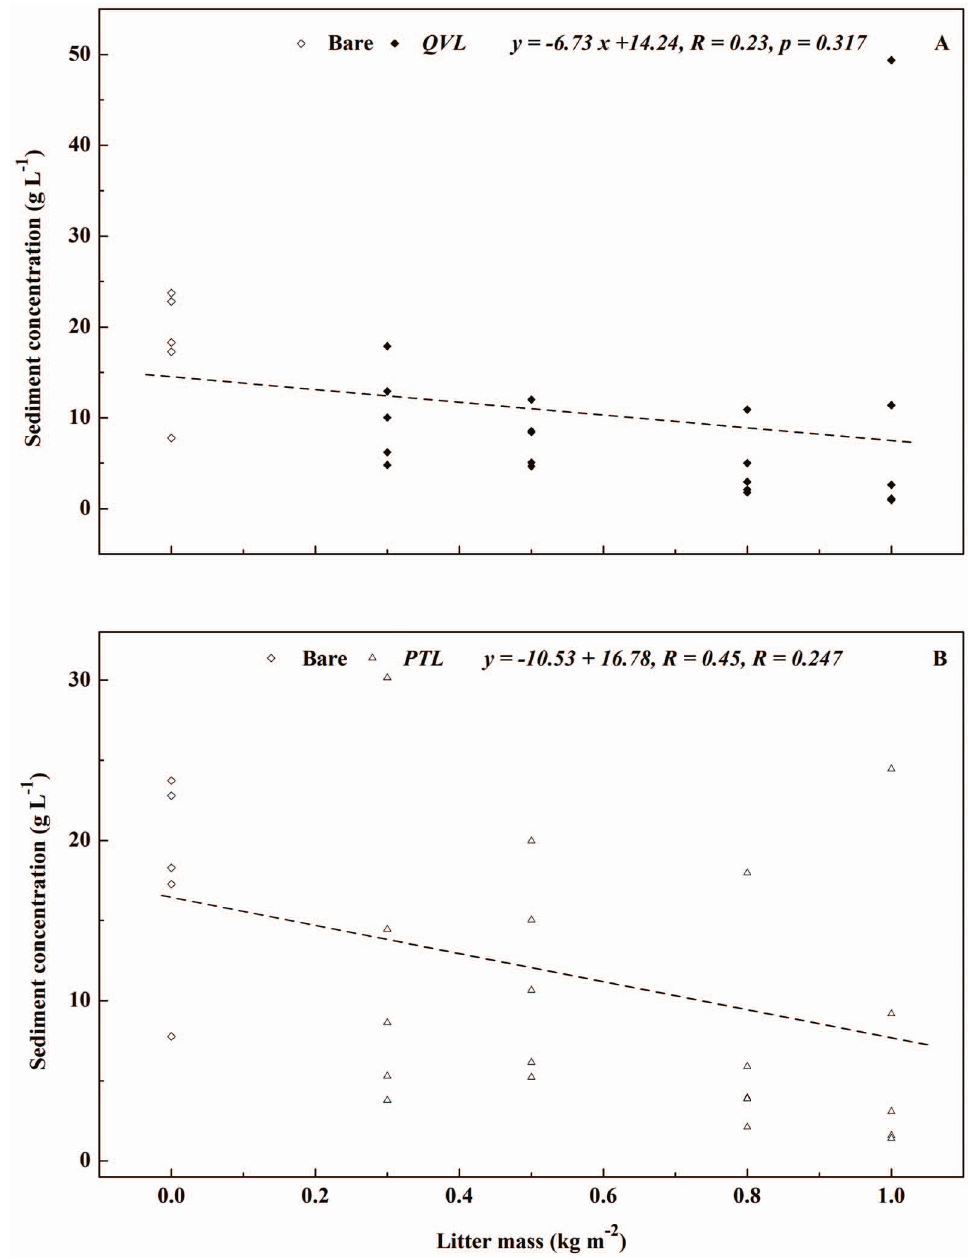
Figure 8. Relationship between litter mass and sediment concentration for bare-soil plots (open diamonds), Quercusvariabilis litter (closed diamonds), and Pinustabulaeformis litter (open triangles) for four litter masses.